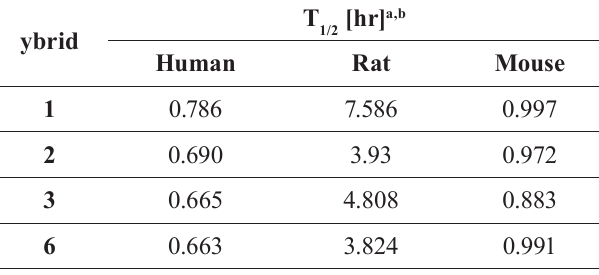
TABLE V - P redicted metabolic stabilities for hybrids 1-3,6